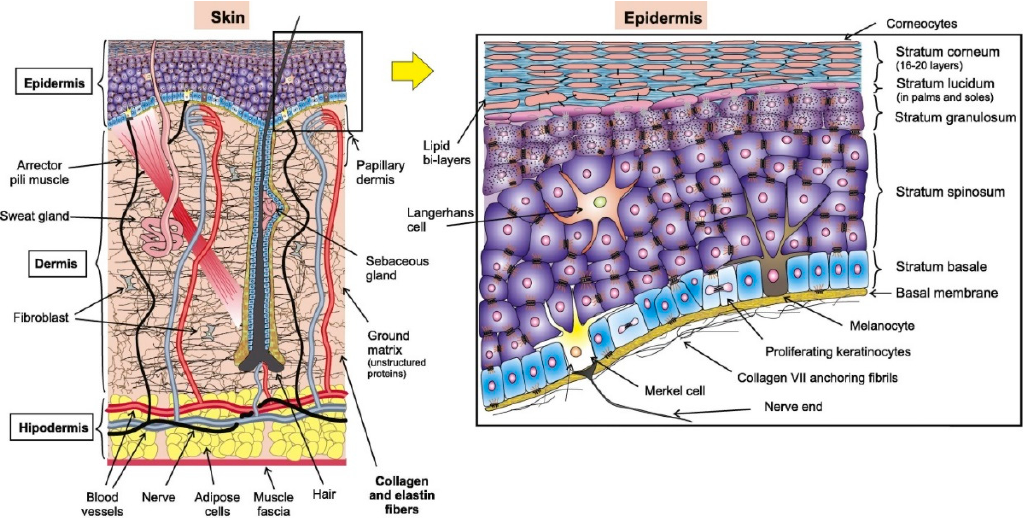
Figure 2. Illustration of the different layers of the skin.